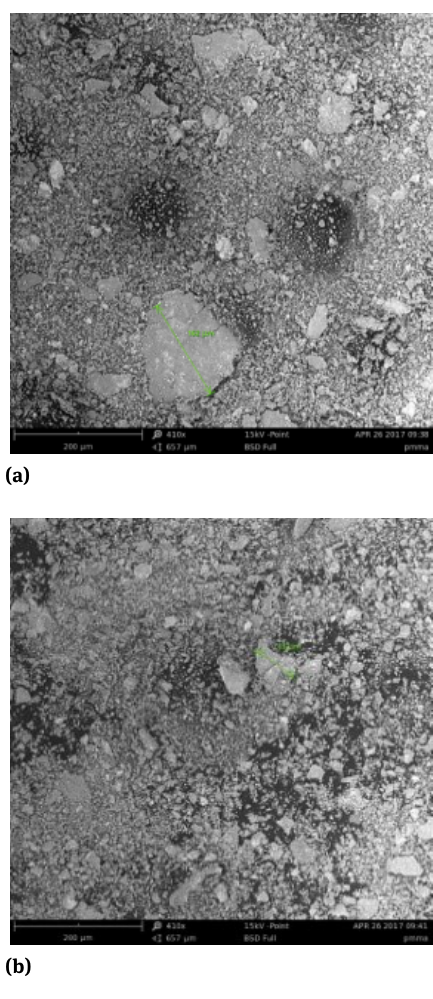
Figure 13: Detailed features of collected wear debris generated during the wear test from SEM Philips XL30 micrograph analysis under fixed normal load ( F N ) 40 kN and at linear sliding velocity ( S V ) of 6.35 cm/s